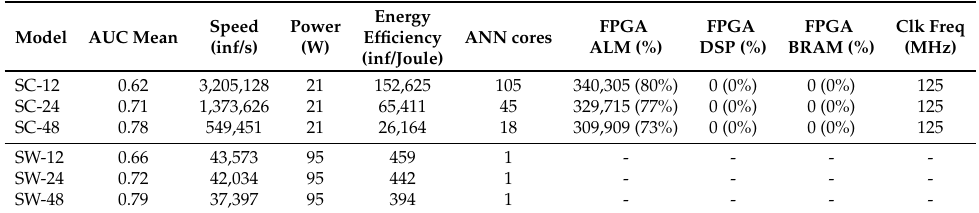
Table 1. Performance comparison between FPGA measurements and software simulations for several ANN